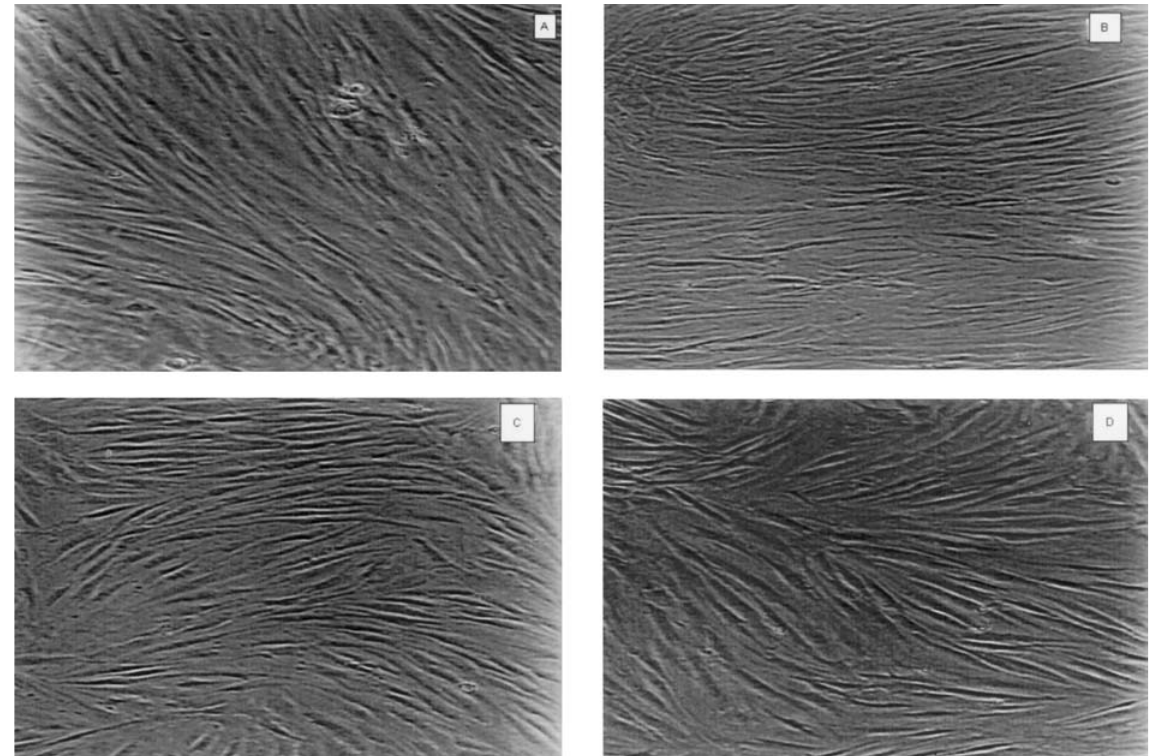
Figure 2 - Photograph of fibroblasts without (a) and after cephalothin 1.5 µ g/mL (b), 3 µ g/mL (c) and 4.5 µ g/mL (d) addition. (X 40).